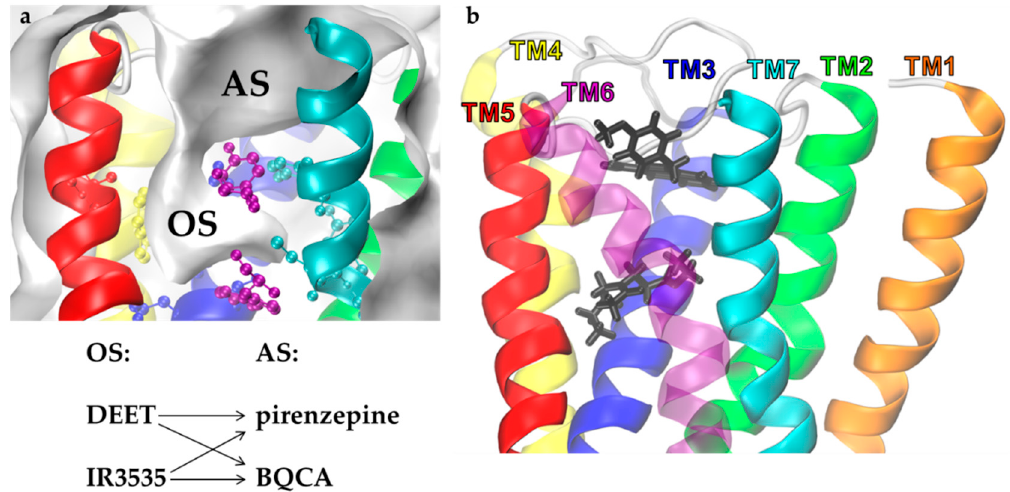
Figure 6. Multiple molecular docking of insect repellents and modulators to the human M1 mus- carinic receptor. ( a ) Surface representation of orthosteric (OS) and allosteric (AS) sites of M1 receptor and scheme of multiple docking protocol. ( b ) Docking poses of IR3535 in the OS (bottom, black) and BQCA in the AS (top, black); the key residues of OS are marked.